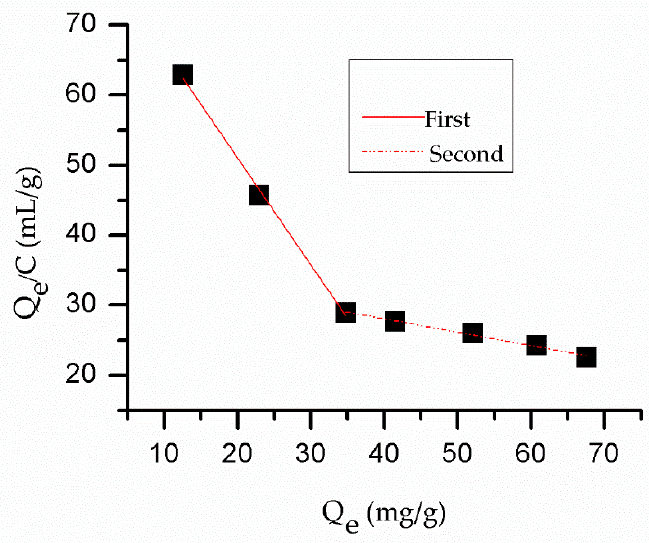
Figure 13. The Scatchard model curve of the SSO-MIPs.